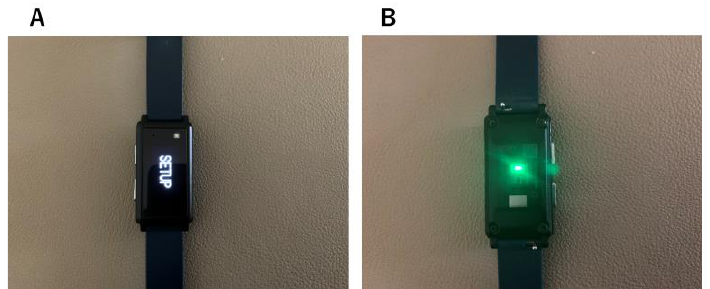
Figure 1. Wearable sensor (Silmee W22). The front side ( A ) contains UV light and conversation volume sensors, and the back side ( B ) contains pulse rate and skin temperature sensors.